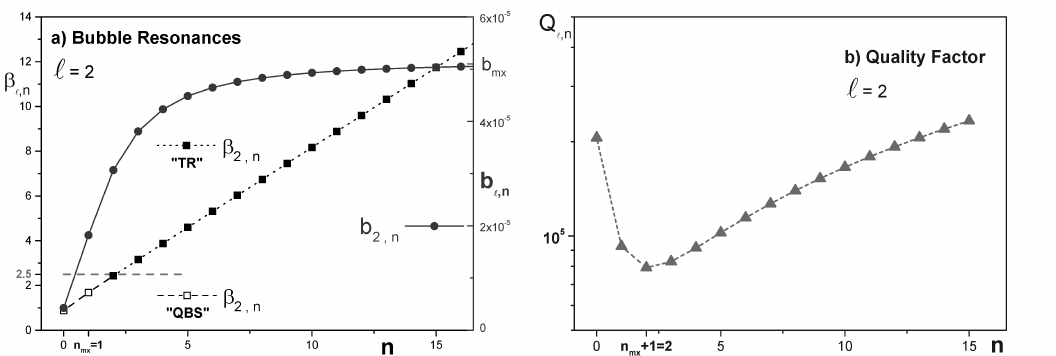
Figure 7 - For (cid:96) = 2 and for several resonances orders n , shows in panel ( a ) in a double vertical axis the resonance position ( β (cid:96),n , left vertical axis) as well as the resonance width ( b (cid:96),n , right vertical axis), in case for Bubble’s Quasi- Bound State (QBS) and Transmission (TR) Resonances. The panel ( b ) shows the behavior of the Q (cid:96),n –factor as n